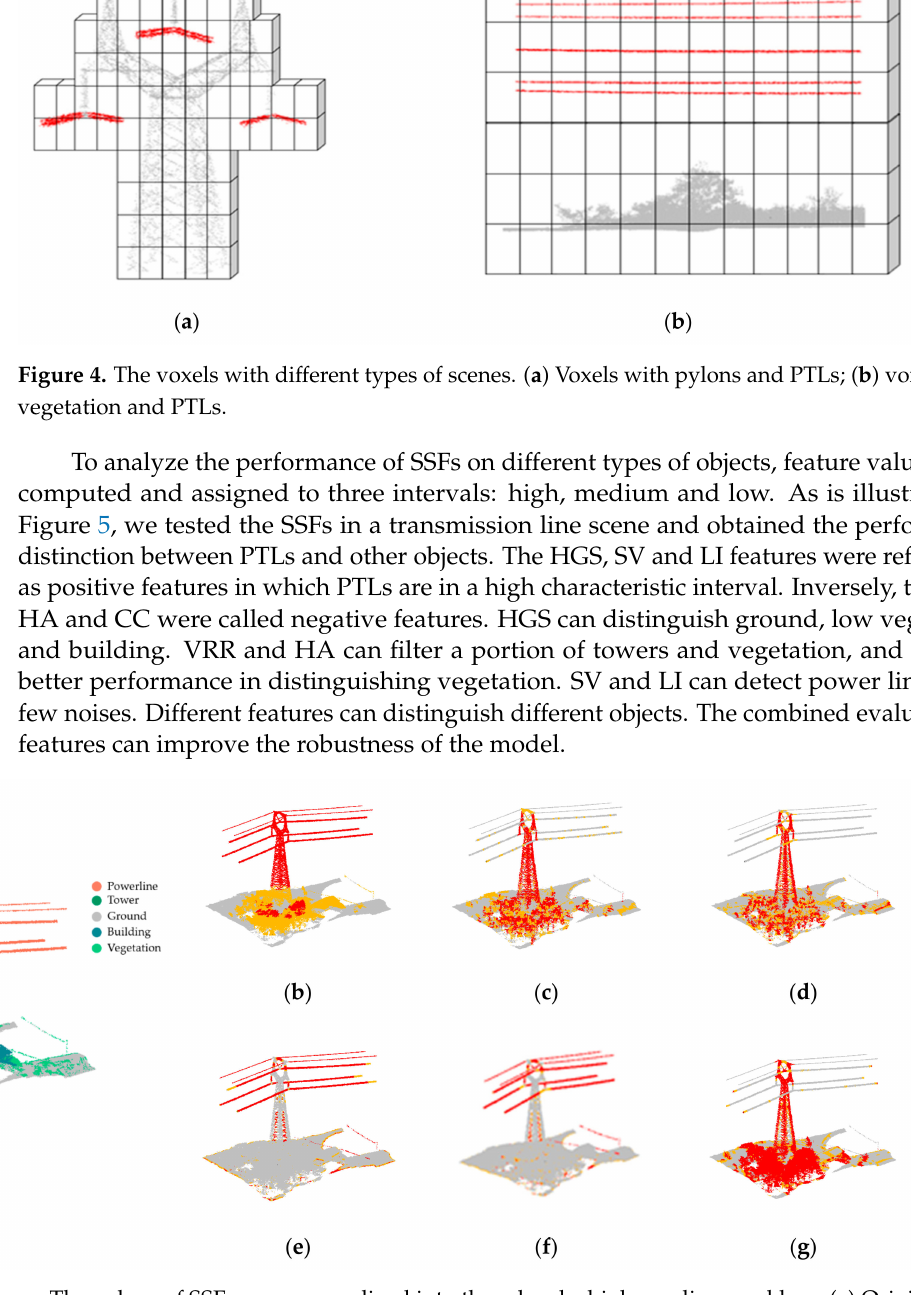
Figure 5. Feature significance. The values of SSFs were normalized into three levels: high, medium and low: ( a ) Original point clouds with categories; ( b – g ) the different performances of the HGS, VRR, HA, SV, LI and CC features. The orange represents high performance, where the point clouds are on a high level. The yellow represents points on medium level. The gray represents points on low